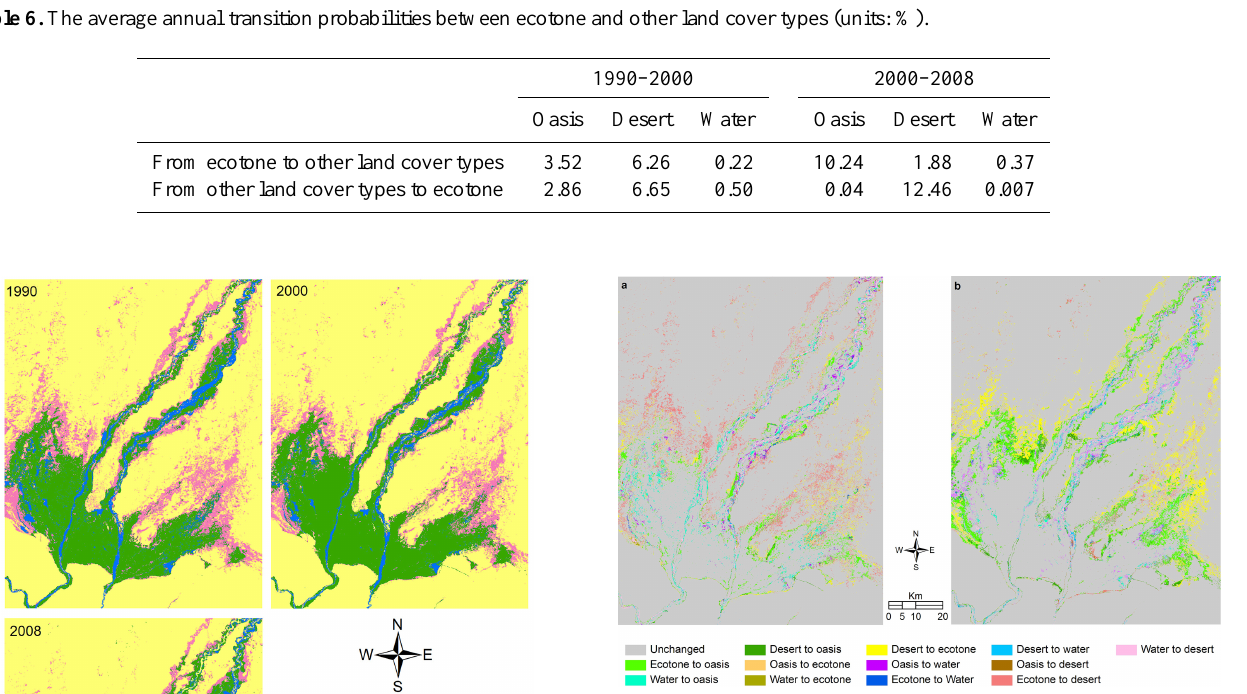
Figure 3. Land cover change maps of the Hotan Oasis during